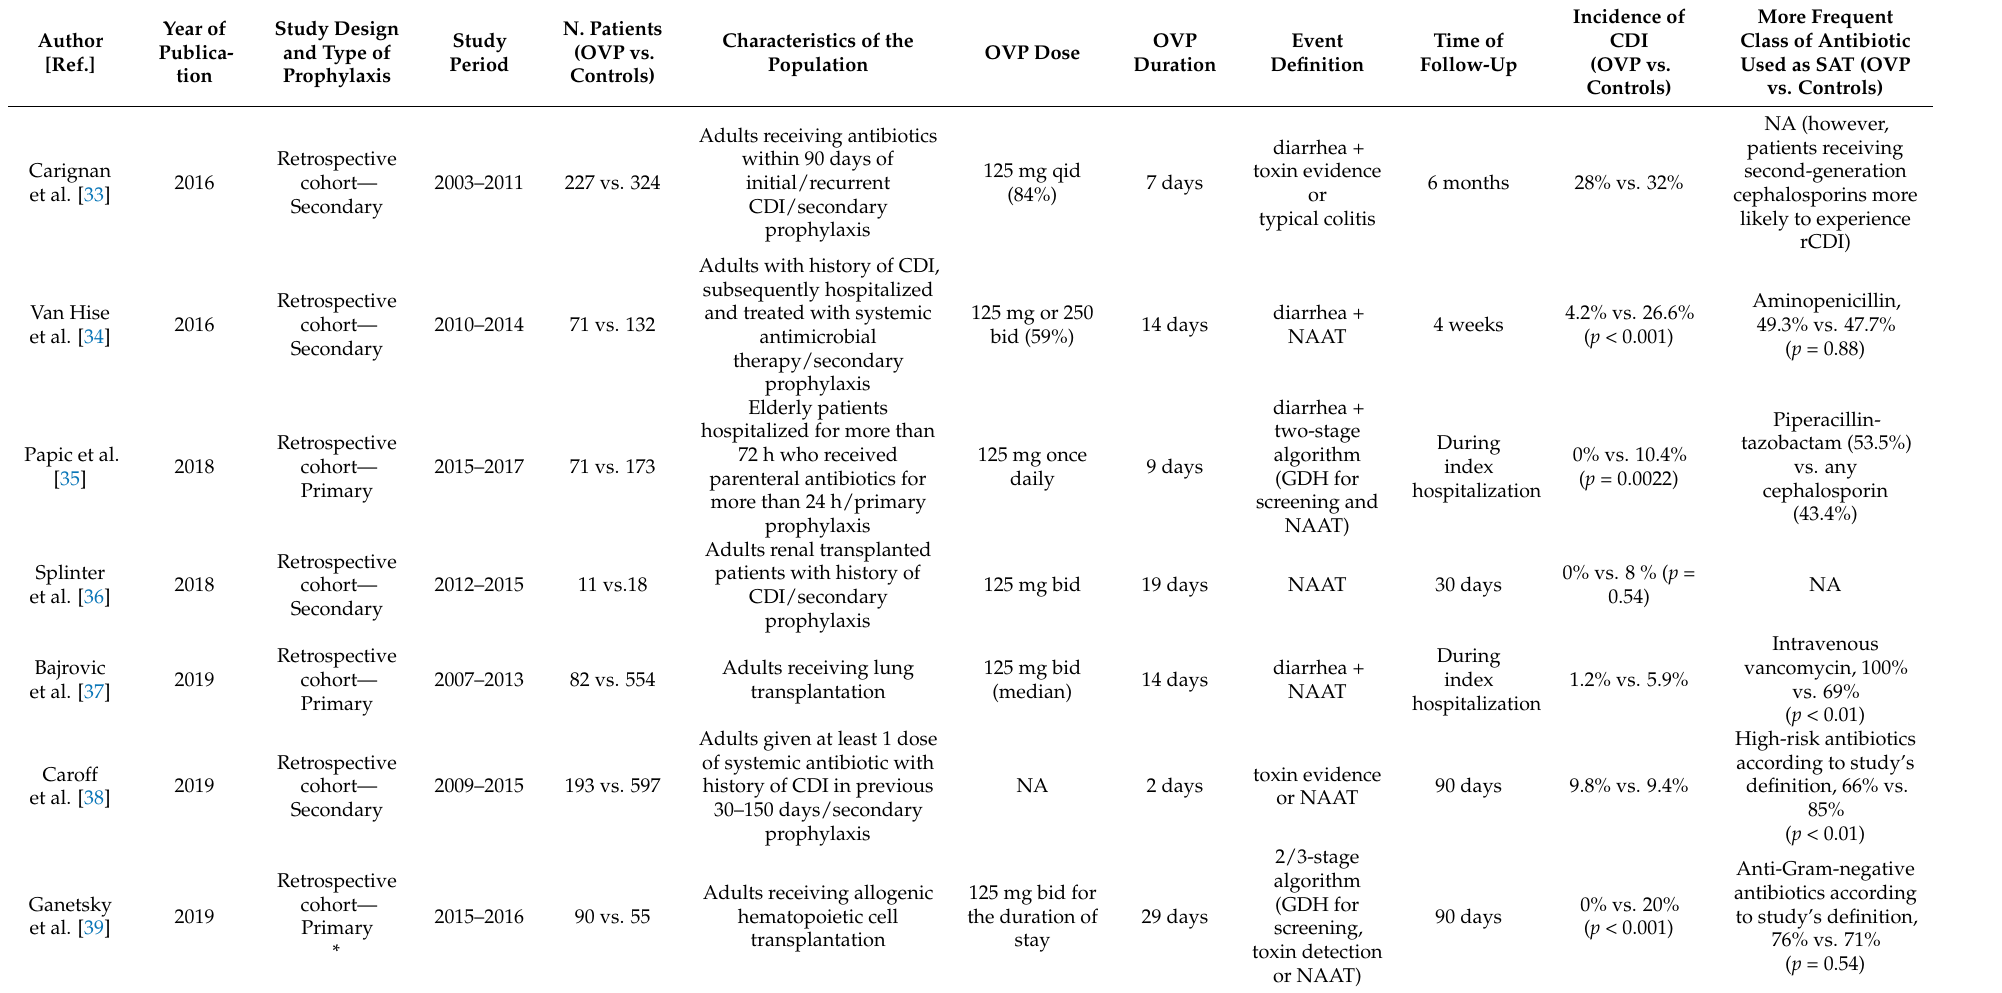
Table 1. Characteristics of included